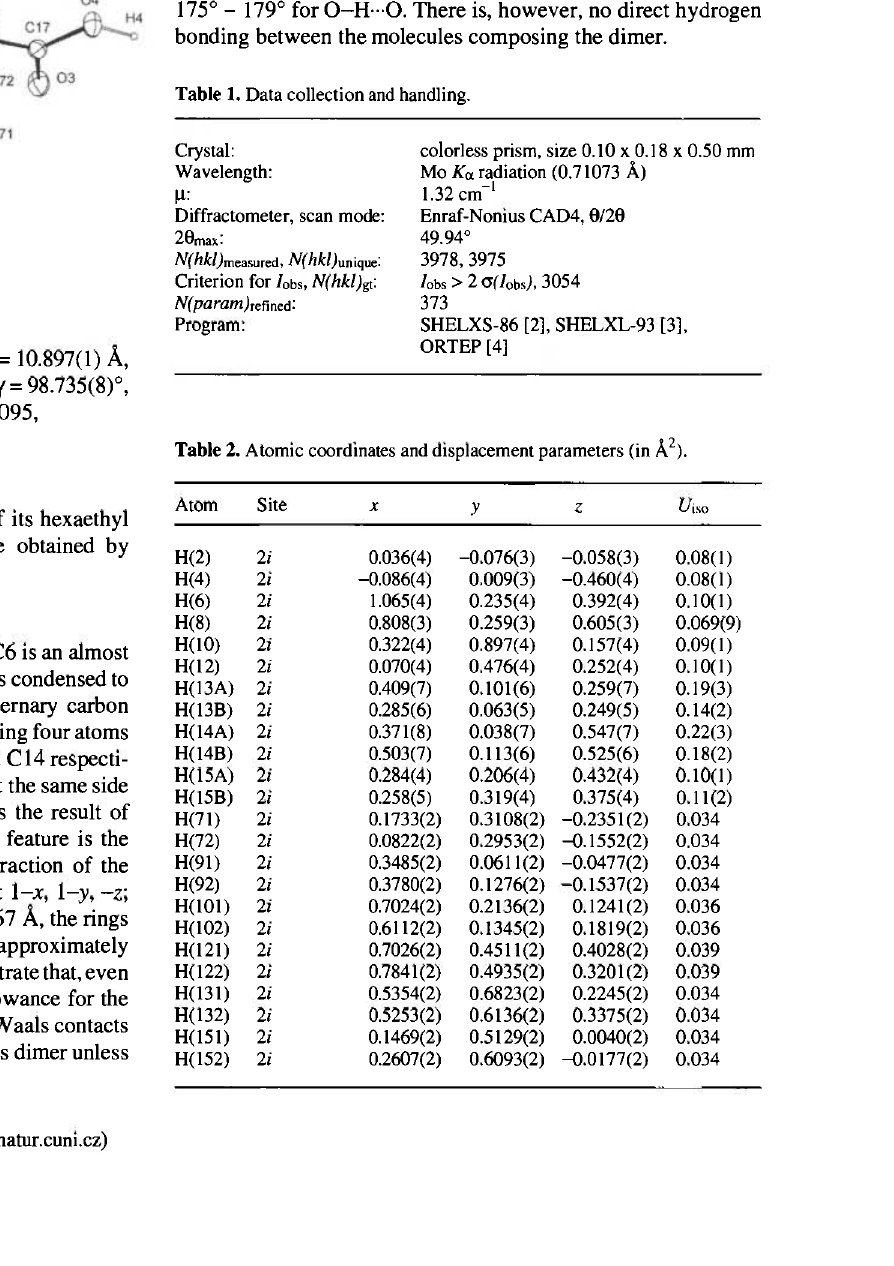
Table 1. Data collection and handling. Crystal: